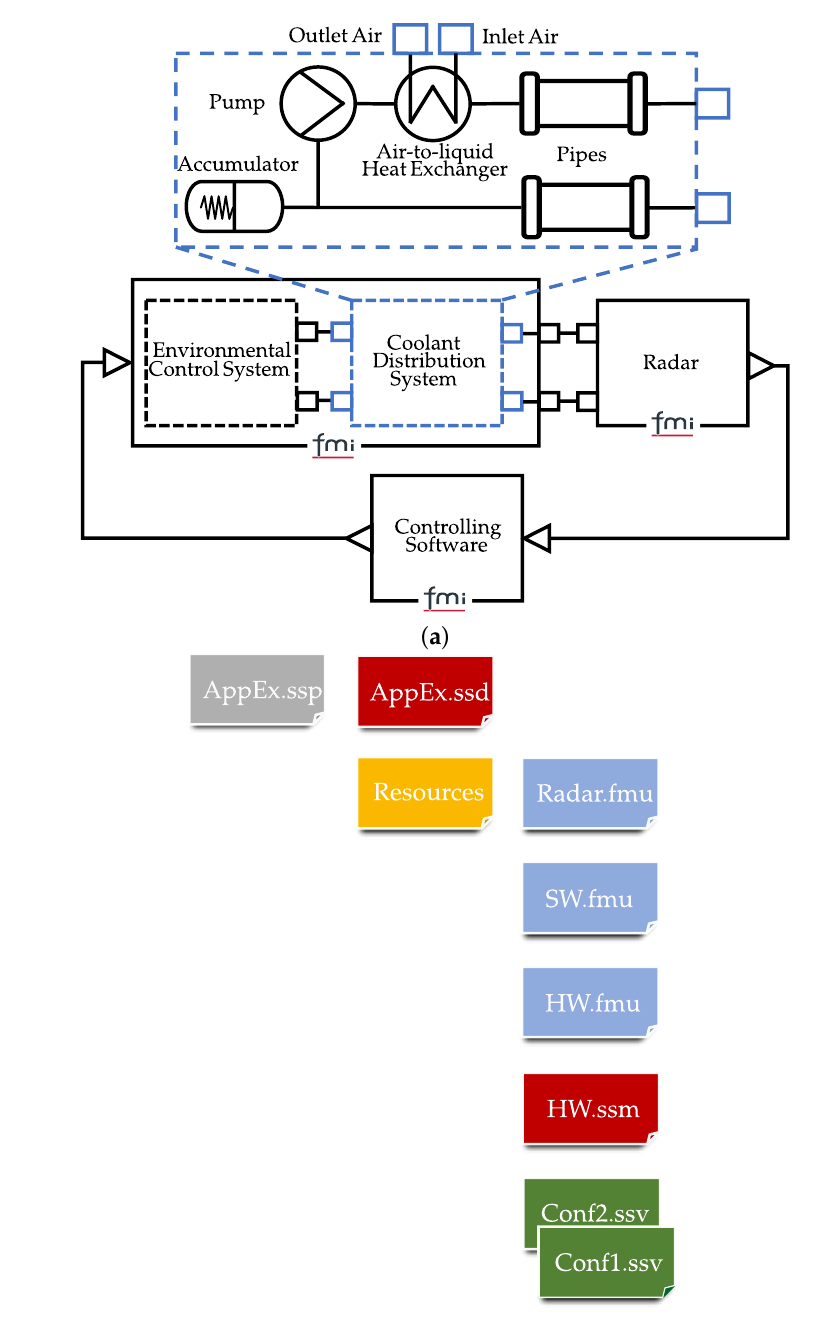
Figure 3. Application example description. A schematic description representing both the application example architectures is presented in ( a ). The structure of the application example one resulting SSP file is provided in ( b ). ( a ) Schematic description capturing both application examples. The dashed Coolant Distribution System is highlighted as its parameters are specified in the geometry modeling domain and exchanged using the concepts of the SSP standard. The individual parts of the application example are exported using the FMI standard. ( b ) Application example one SSP file structure. The SSP file represents two different simulator geometrical configurations via the two different incorporated SSV files Conf1.ssv and Conf2.ssv . The simulator architecture is described in the AppEx.ssd file. The SSP of the second application example merely describes a single configuration including one FMU, one SSV, and one